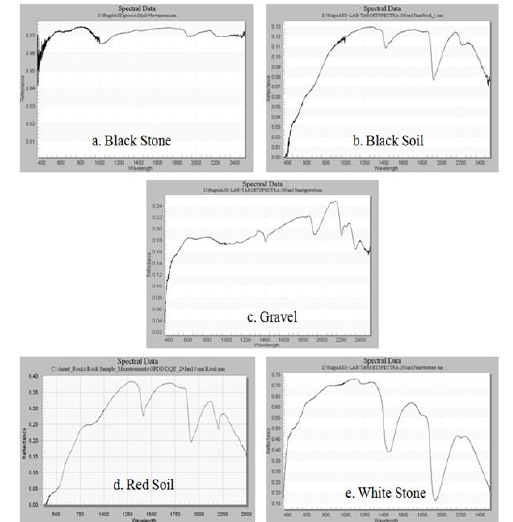
Figure 5. Spectral reflectance curves for five target materials